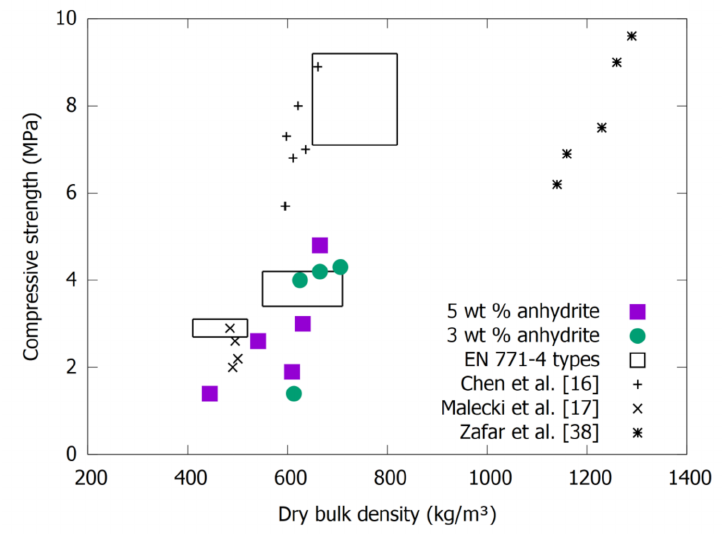
Figure 13. Strength-density relation of the AAC blocks compared to the density classes defined in EN 771-4 and to data from